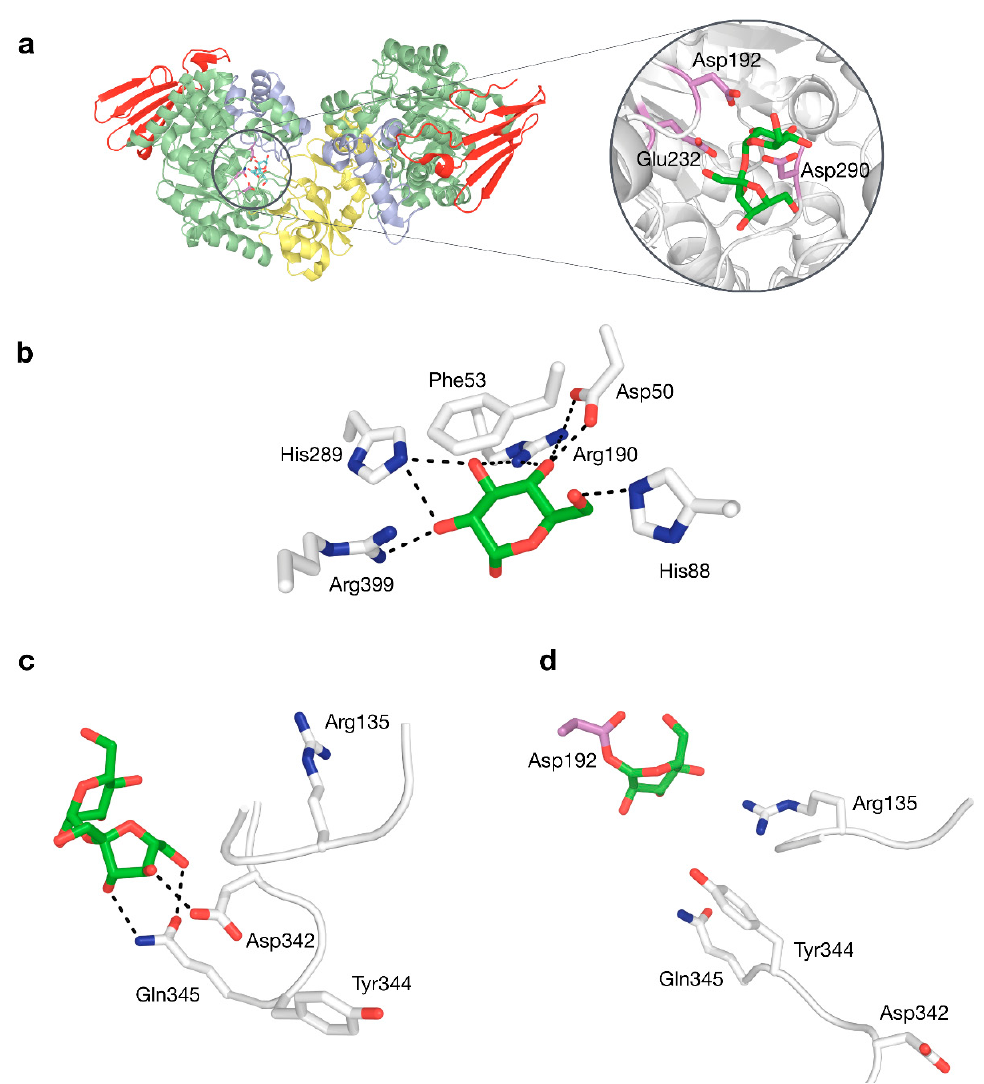
Figure 4. ( a ) Three-dimensional structure of BaSP with a close-up view of sucrose bound to the active site, with the catalytic triad shown in violet. ( b ) Interactions to glucosyl moiety in subsite − 1. ( c ) Interactions to fructosyl moiety in subsite + 1 by residues in flexible loops. ( d ) Rearranged phosphate-binding conformation of flexible loops in subsite +1.